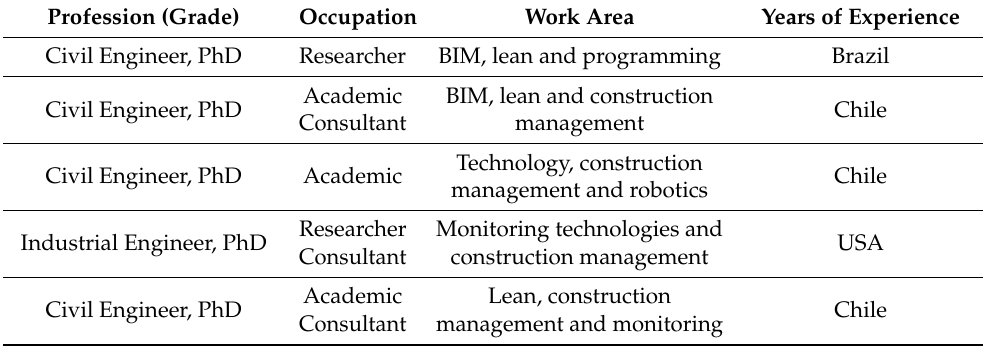
Table 6. Characterization of expert